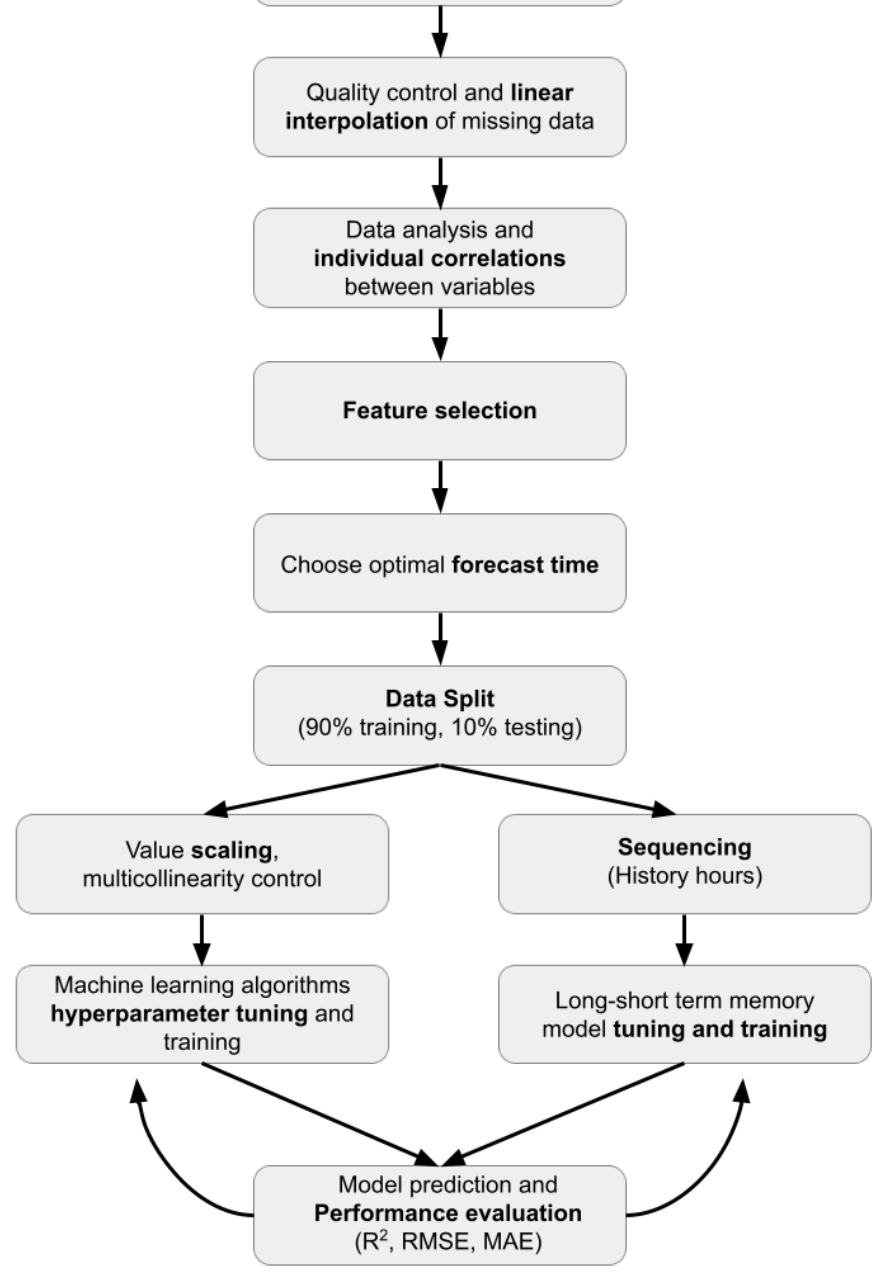
Figure 2. Flow chart of input data processing and analysis of the